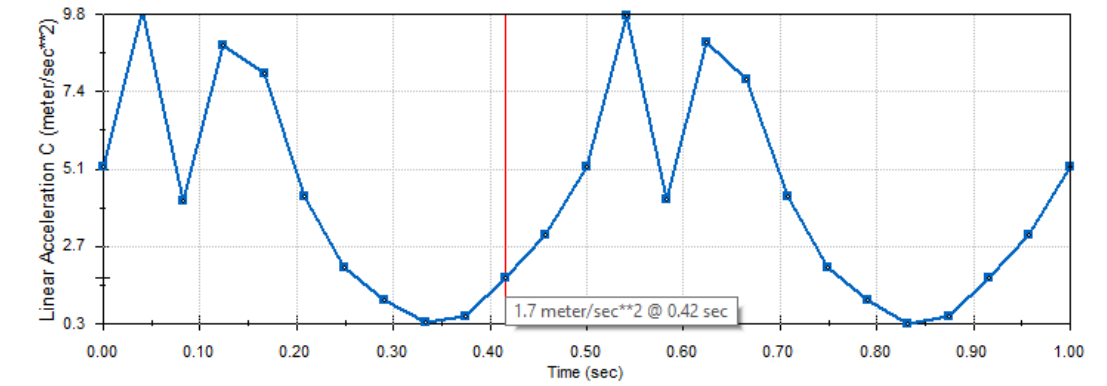
Figure 9. Linear acceleration distribution of the coupling C.